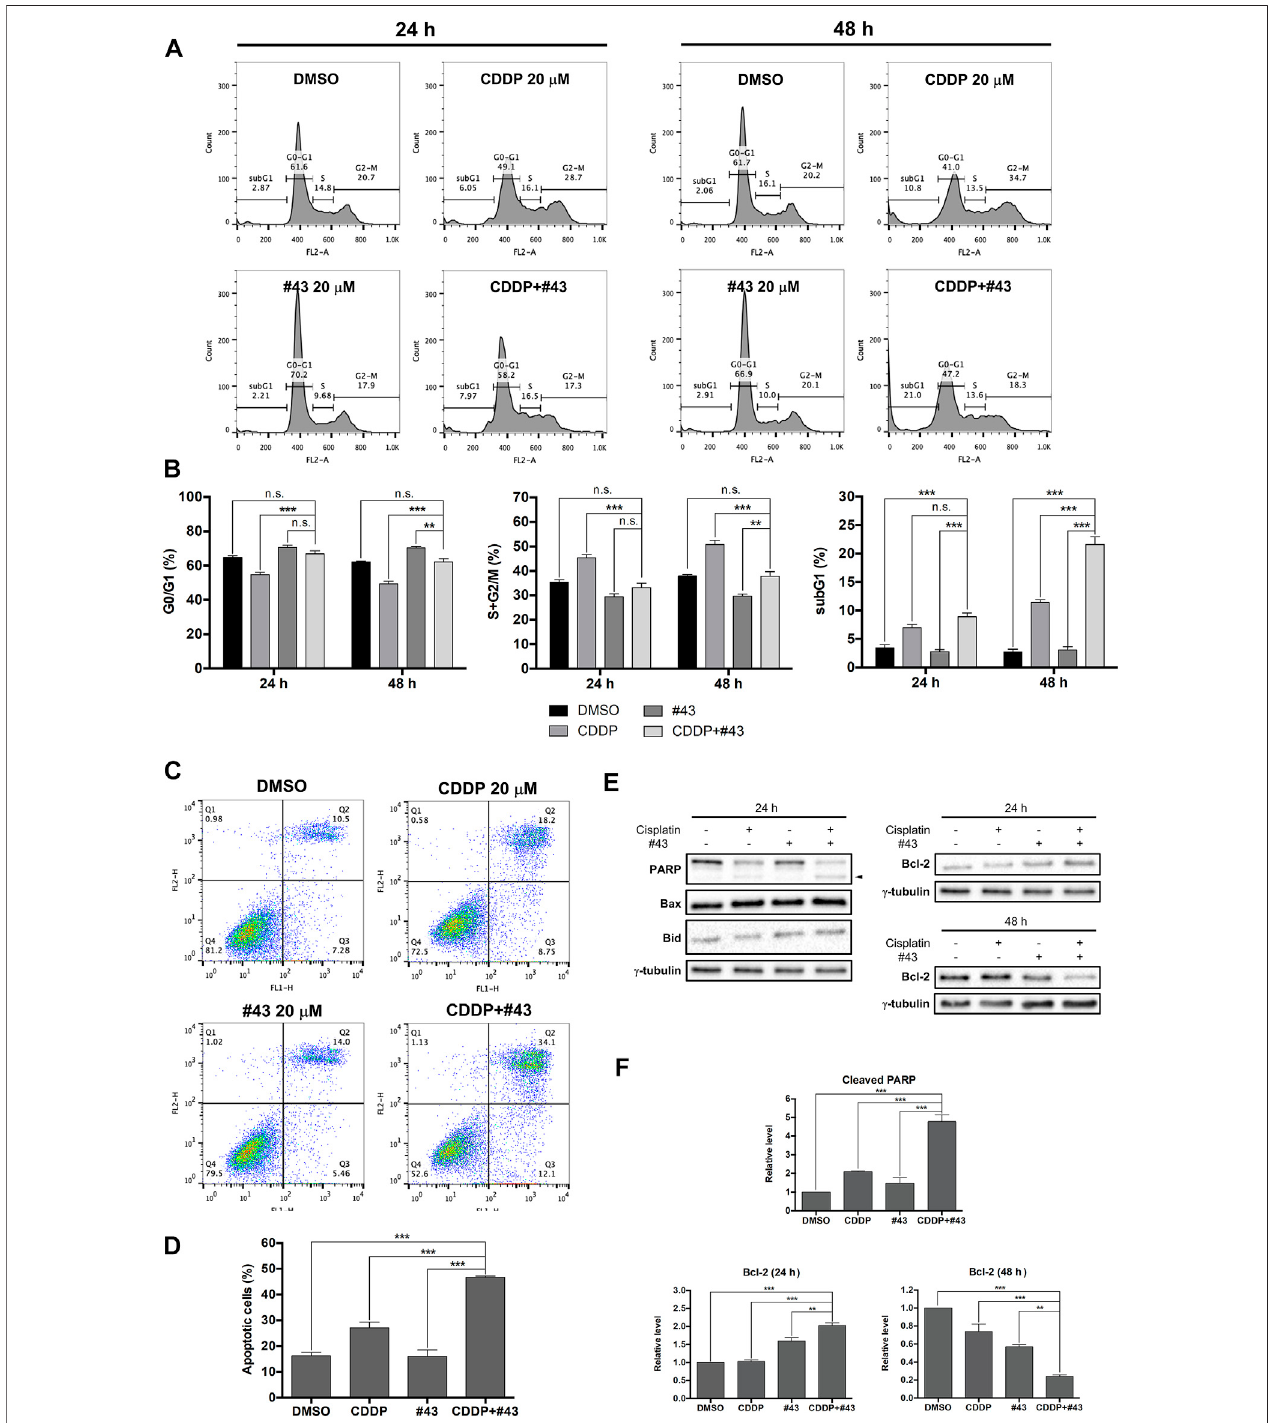
FIGURE 3 | Effects of cisplatin and #43 on cell cycle progression and apoptosis in MCF-7 cells. (A) Representative histograms of cell cycle analysis. Cells were treated with 20 μ M cisplatin and/or 20 μ M #43 for 24 and 48 h, followed by PI staining and fl ow cytometric analysis. (B) Quantitative results of G0/G1, S + G2/M, and subG1 populations. (C) Dot plots of Annexin V-FITC/PI double staining after 48 h of 20 μ M cisplatin and/or 20 μ M #43 treatment. (D) Quantitative results of Annexin V-FITC/PI fl owcytometric analysis.Cells inQ2and Q3werecalculatedasapoptotic cells. (E) Western blotanalysisofapoptosis-related proteins. Cleaved PARPis marked with an arrowhead. (F) Quantitative results of Western blot analysis. Cells were treated with 20 μ M cisplatin and/or 20 μ M #43 for 24 or 48 h and harvested for Western blot analysis. The relative protein levels were quanti fi ed by Image Lab software and γ -tubulin was used as the loading control. Data are presented as mean ± SEM of at least three independent experiments. *, p < 0.05; **, p < 0.01; ***, p < 0.001; n. s., not signi fi cant ( p > 0.05) by one-way ANOVA followed by Bonferroni t -test.